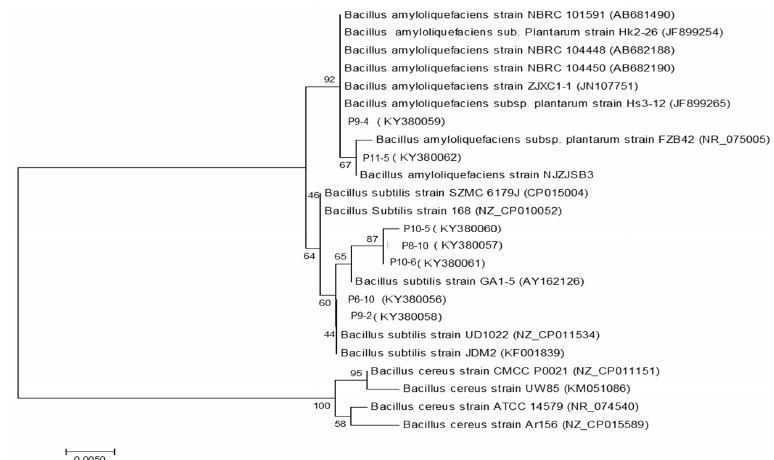
Figure 3. Phylogenetic tree of the seven Bacillus isolates (P6-10, P8-10, P9-2, P9-4, P10-5, P10-6 and P11-5) and closely related species based on 16S rDNA gene sequences, obtained from NCBI following BLAST analysis. The tree was constructed by the neighbor-joining method. The scales indicate the evolutionary distance of the nucleotide substitutions per site. Bootstrap values, derived from 1000 replicates, are indicated as percentage at all branches.